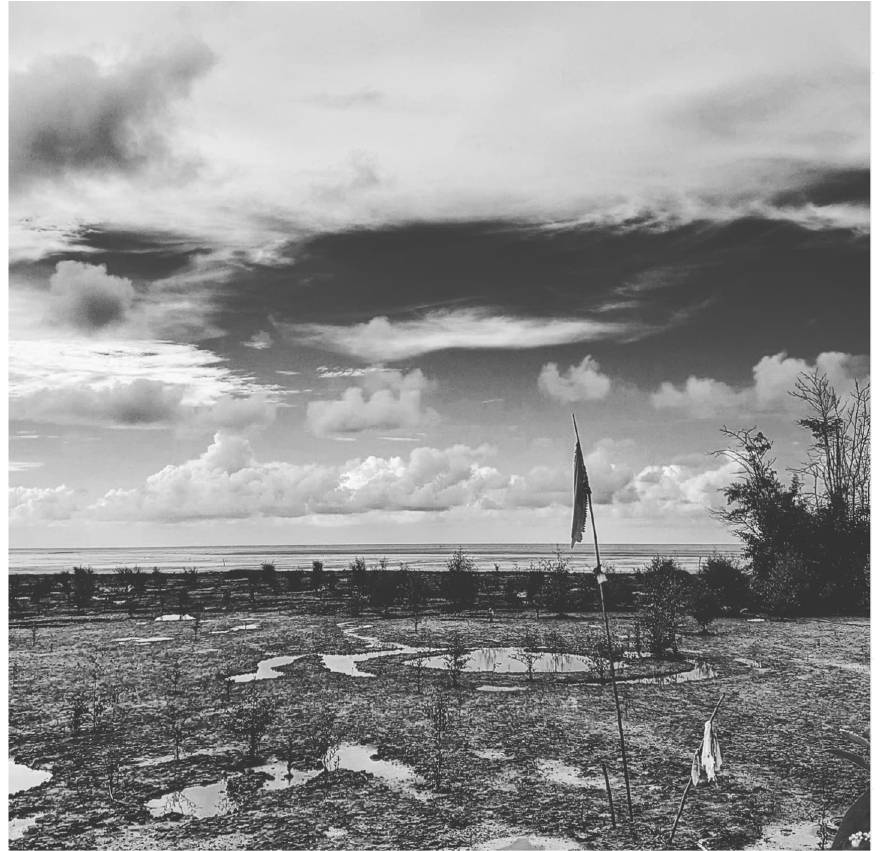
Figure 5. Michael Lam, Annandale (Demerara, Mahaica) from the series, Oniabo , 2017. After indenture ended and into present day Guyana, the presence of jhan. d. ¯ı